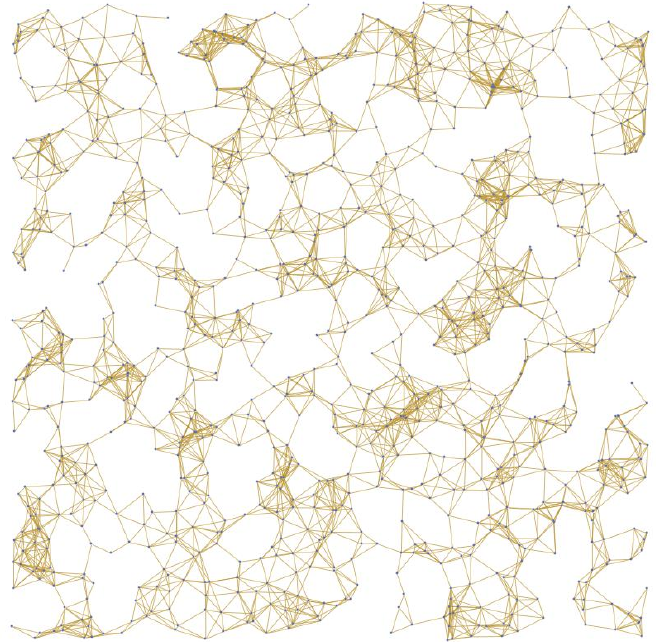
Figure 3. A snapshot of a geometric random graph with N = 1000 and transmission range r c = 0.052. It depicts a marginally-connected WSN from which it can be visually understood why there is a significant time lag in the network coverage of a random walker, compared to denser networks. One can easily observe the existence of small bottlenecks dispersed over the